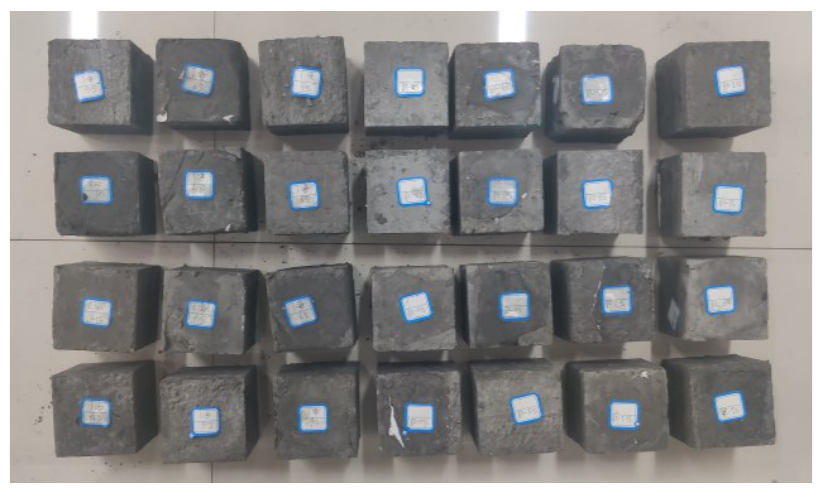
Figure 8. Partial specimen of CBSWCB.